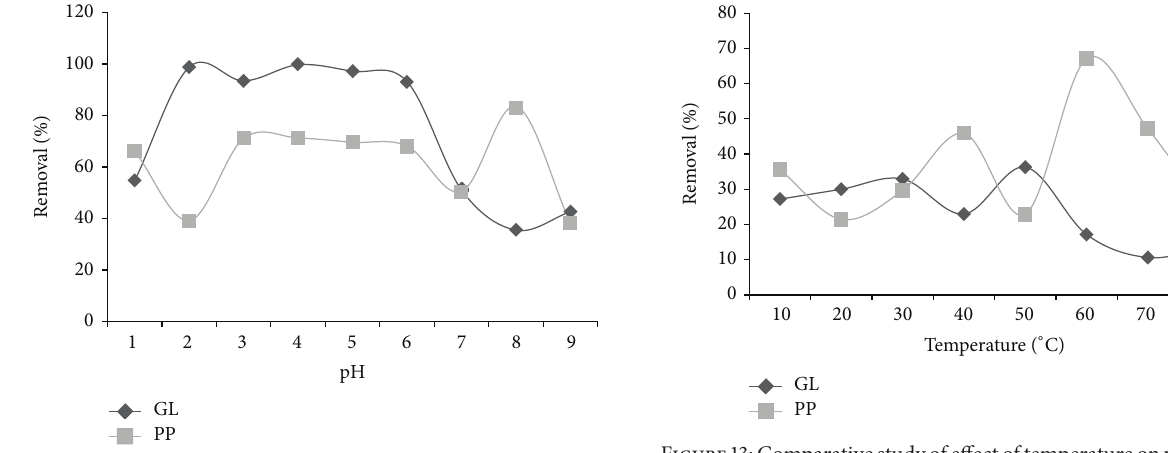
Figure 11: Comparative study of effect of pH on percentage removal of BG.